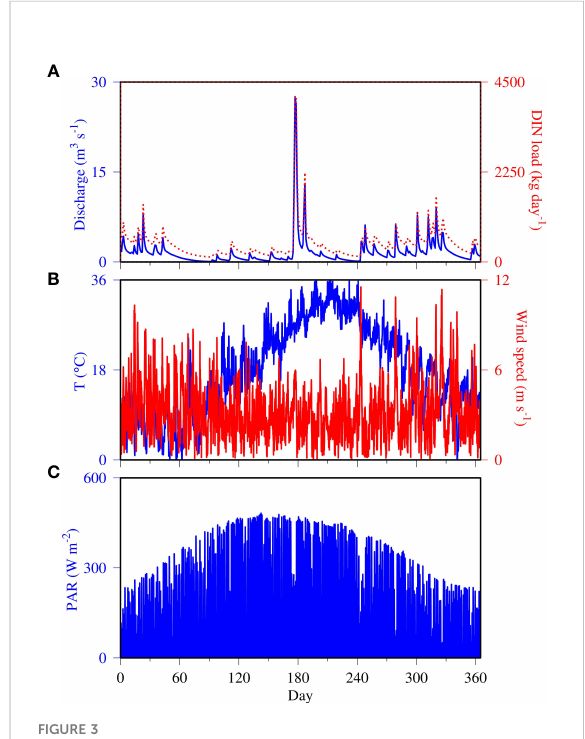
FIGURE 3 Model forcing data for the calendar year 2006, including (A) Total freshwater discharge (blue line) and dissolved inorganic nitrogen (DIN) load (red dashed line), (B) Air temperature (blue line) and wind speed (red line), and (C) Photosynthetically active radiation